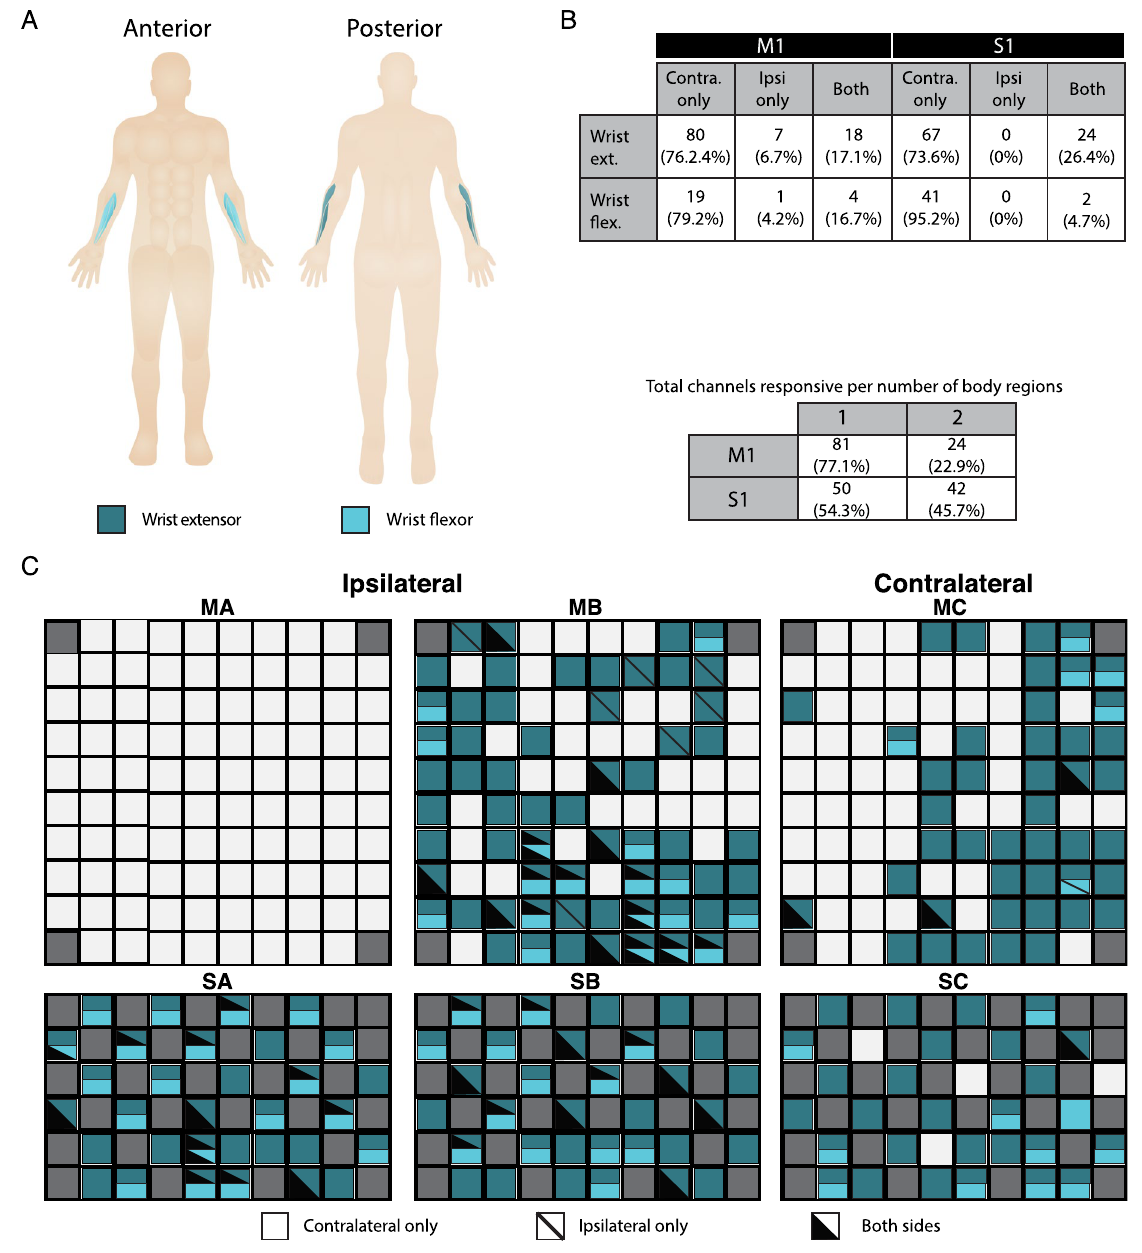
Figure 2. Regional body map for wrists, showing activity patterns across individual muscles. A : Overview of assessed muscles, color-coded by group. Targeted groups were: wrist extensors–-extensor carpi radialis; wrist flexors: flexor carpi radialis. B : Summary of channel-level representation of each muscle by brain area (M1: motor cortex arrays; S1: sensory cortex arrays) and laterality (contralateral, ipsilateral, or both). Counts are raw numbers, and percentages are with respect to all channels active for that region within the indicated brain area. C Activity maps for right hemisphere (MA: motor array, pedestal A; MB: motor array, pedestal B; SA: sensory array, pedestal A; SB: sensory array, pedestal B) and left hemisphere (MC: motor array, pedestal C; SC: sensory array, pedestal C). Channels with significant MUA responses to contractions in a body region are colored as in panel A. Solid colors indicate activity for only the contralateral side of the body (right side for MA/SA/MB/SB, left side for MC/SC); diagonal lines denote activity for the ipsilateral side; and black triangle overlays denote that both sides of the body elicited a